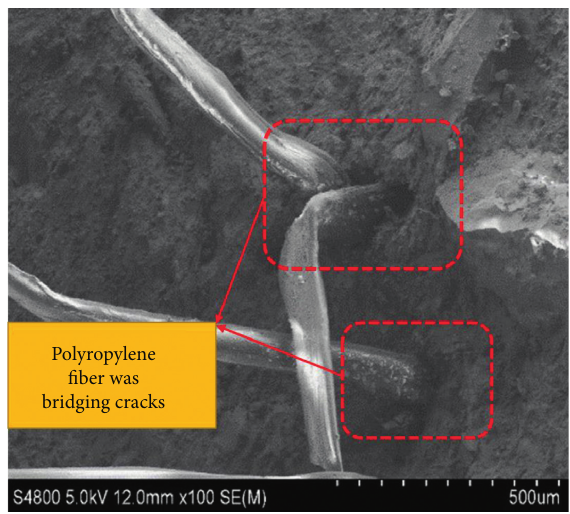
Figure 8: Bonding state of the aggregate in concrete reinforced with polypropylene